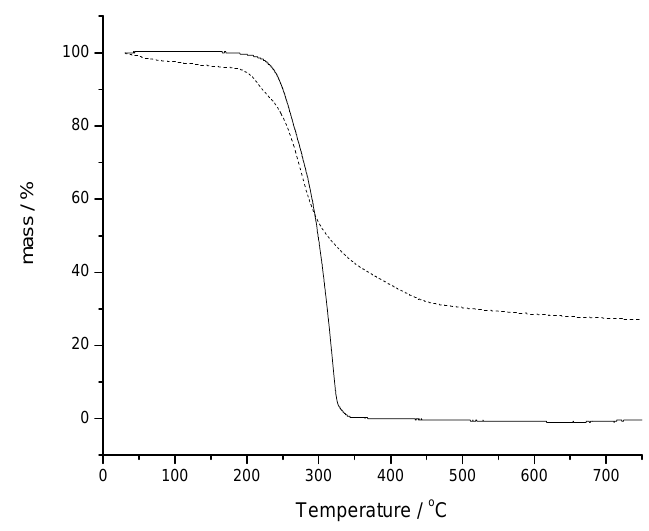
Figure 6. TG curves. Verapamil hydrochloride ( ___ ); and pharmaceutical formulation (---) containing verapamil hydrochloride.